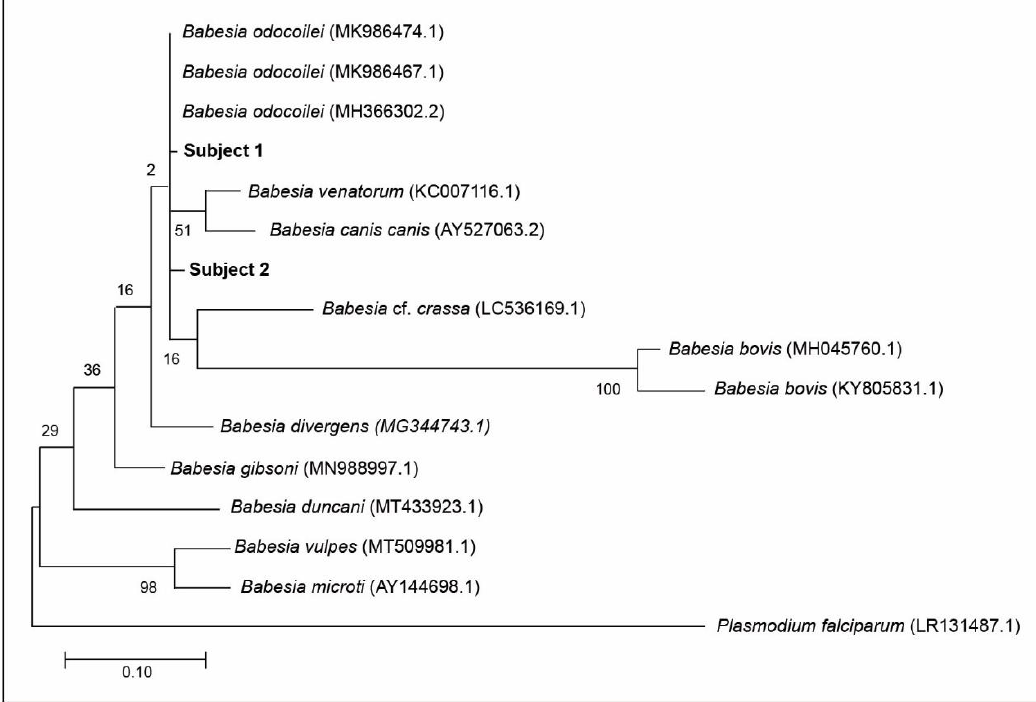
Figure 1. Maximum likelihood phylogenetic tree of 18S rRNA sequences amplified from human blood with 13 published sequences of ten different reference Babesia species for comparison, plus Plasmodium falciparum as an outgroup, represent the relationship of Subject 1 and Subject 2 to other Babesia spp. Alphanumeric values in brackets denote published GenBank sequences. The scale bar represents the percentage of genetic variation along the tree branches.